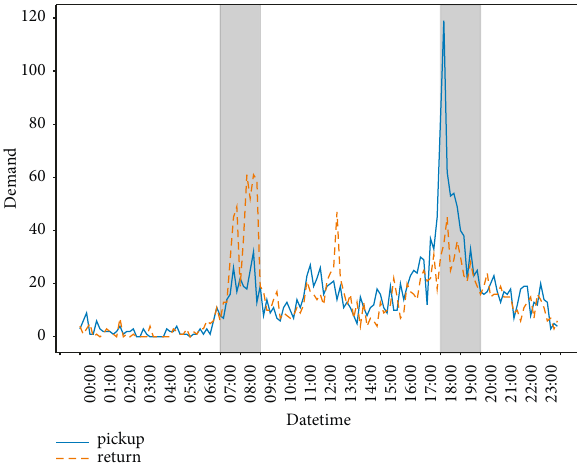
Figure 2: Location of stations and depot in Yeouido, Seoul. Figure